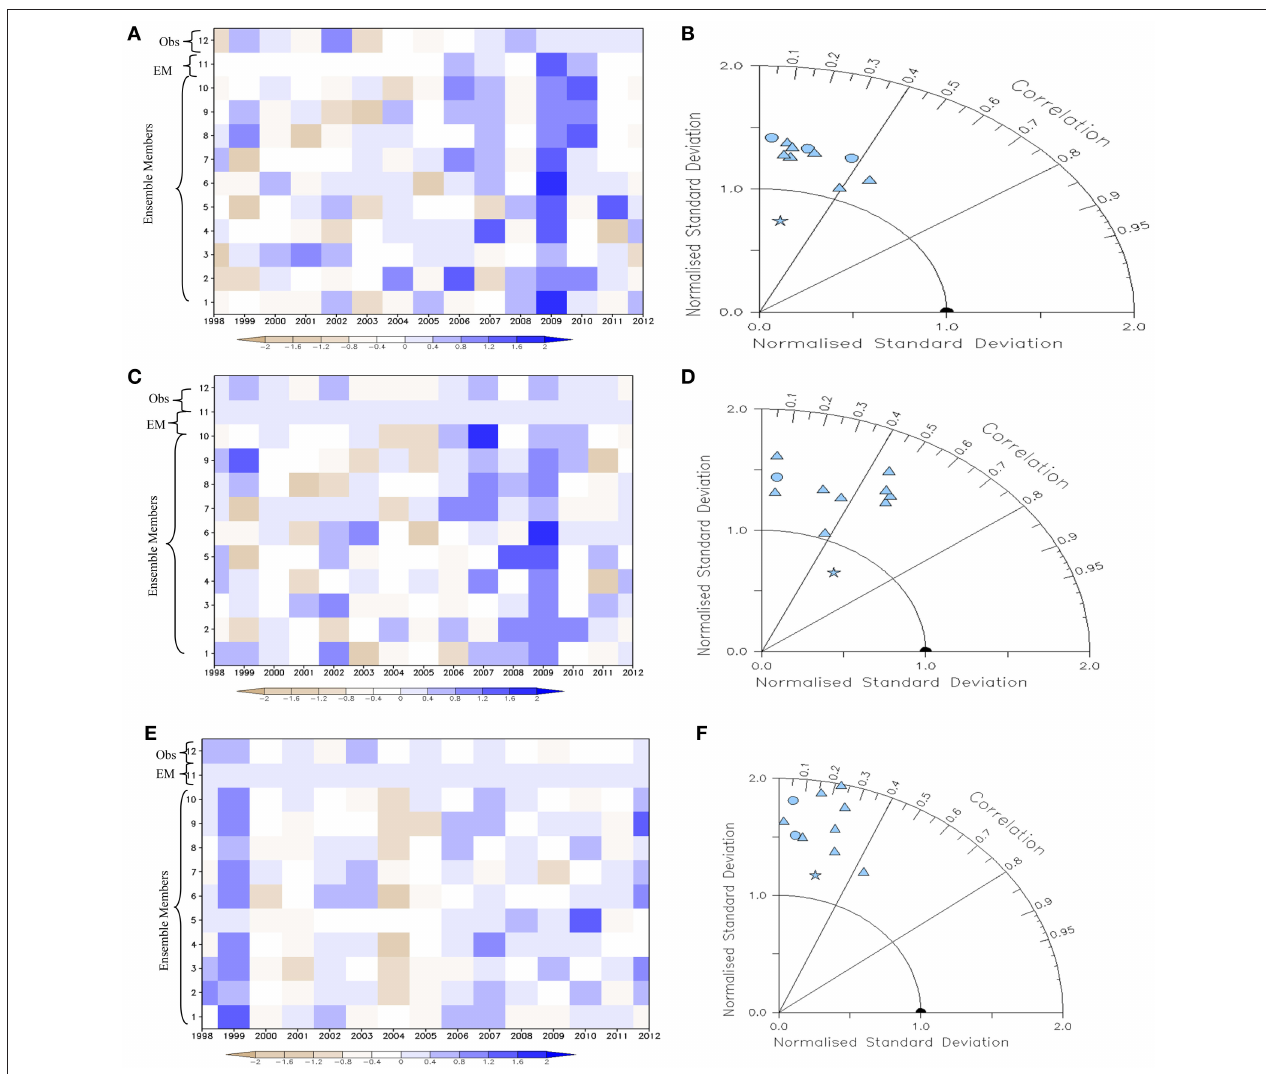
FIGURE 7 | Inter-annual variability of standardized rainfall anomalies over climatological zones of Nigeria (A) GoG, (C) Savannah, and (E) the Sahel [EM—the Ensemble Mean and Obs—the Observation]; (B,D,F) Taylor diagrams showing the normalized standard deviations and the correlation coefficients of S2S ensemble simulations with observation for panels a and c respectively (ensemble members—blue triangle; blue circle for negative correlations), ensemble mean—blue star and Era-Interim (observation)—black semi-circle. The normalized standard deviations and correlations are with reference to Era-Interim over same